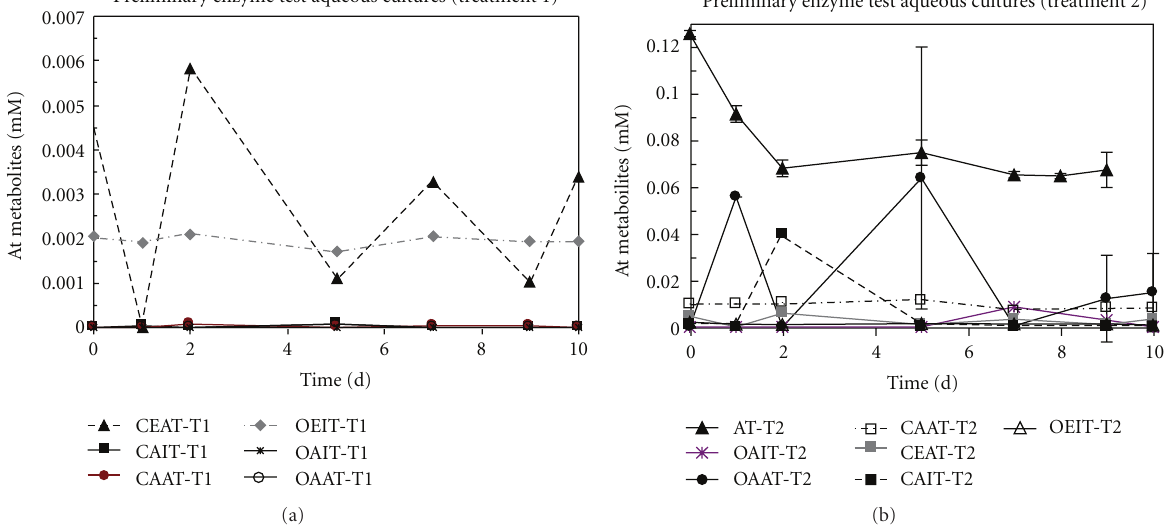
Figure 2: Production of atrazine metabolites during preliminary enzyme test in aqueous cultures. (a) Treatment 1 (EES only). (b) Treatment 2 (EES and H 2 O 2 ). OIET = atrazine-2-hydroxy, CAAT = atrazine deethyl deisopropyl, OAAT = atrazine deethyl deisopropyl-2-hydroxy, CEAT = atrazine deisopropyl, OIAT = atrazine